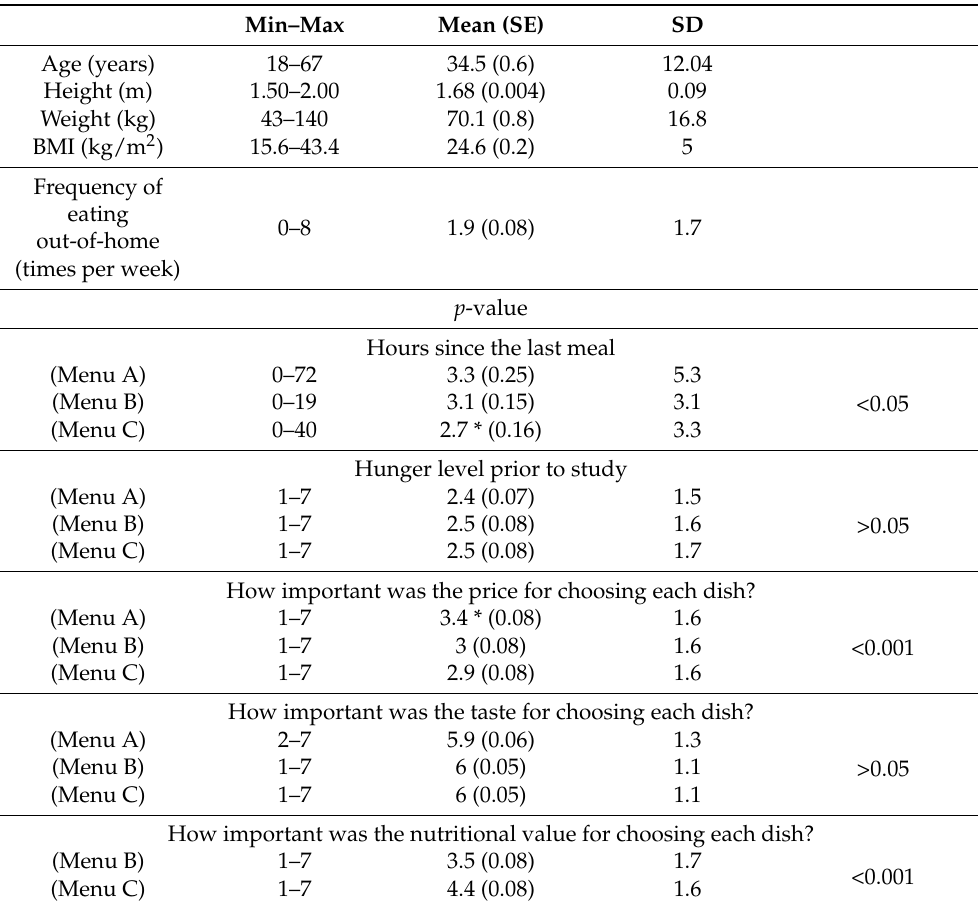
Table 1. Descriptive statistics for the numerical and ordinal variables (The * indicates statistically significant differences according to the Wilcoxon signed ranks test, with statistical significance set at p <